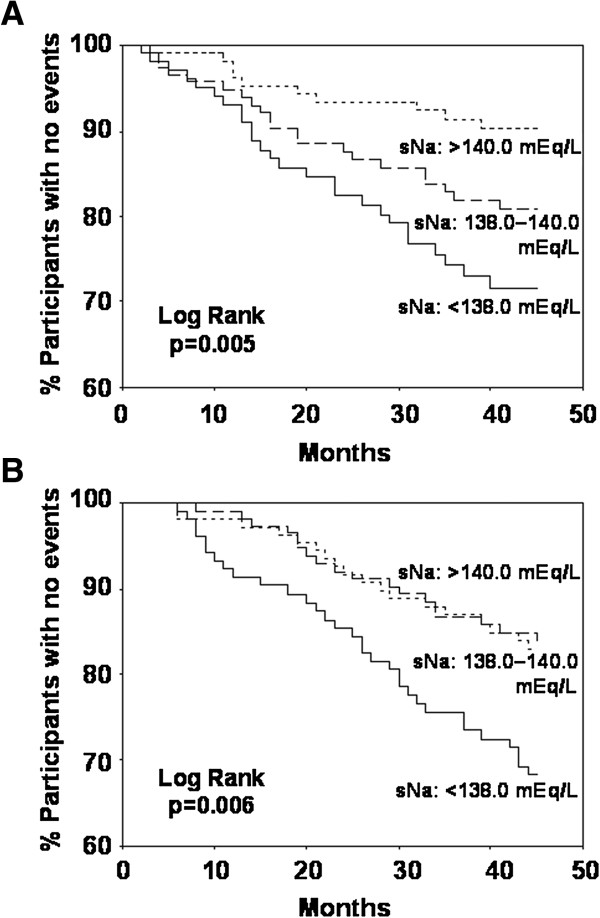
Kaplan-Meier curves of time to outcomes according to serum sodium level tertiles. (A) First infection-related hospitalization. (B) Death of any cause. Abbreviations: sNa, serum sodium level.